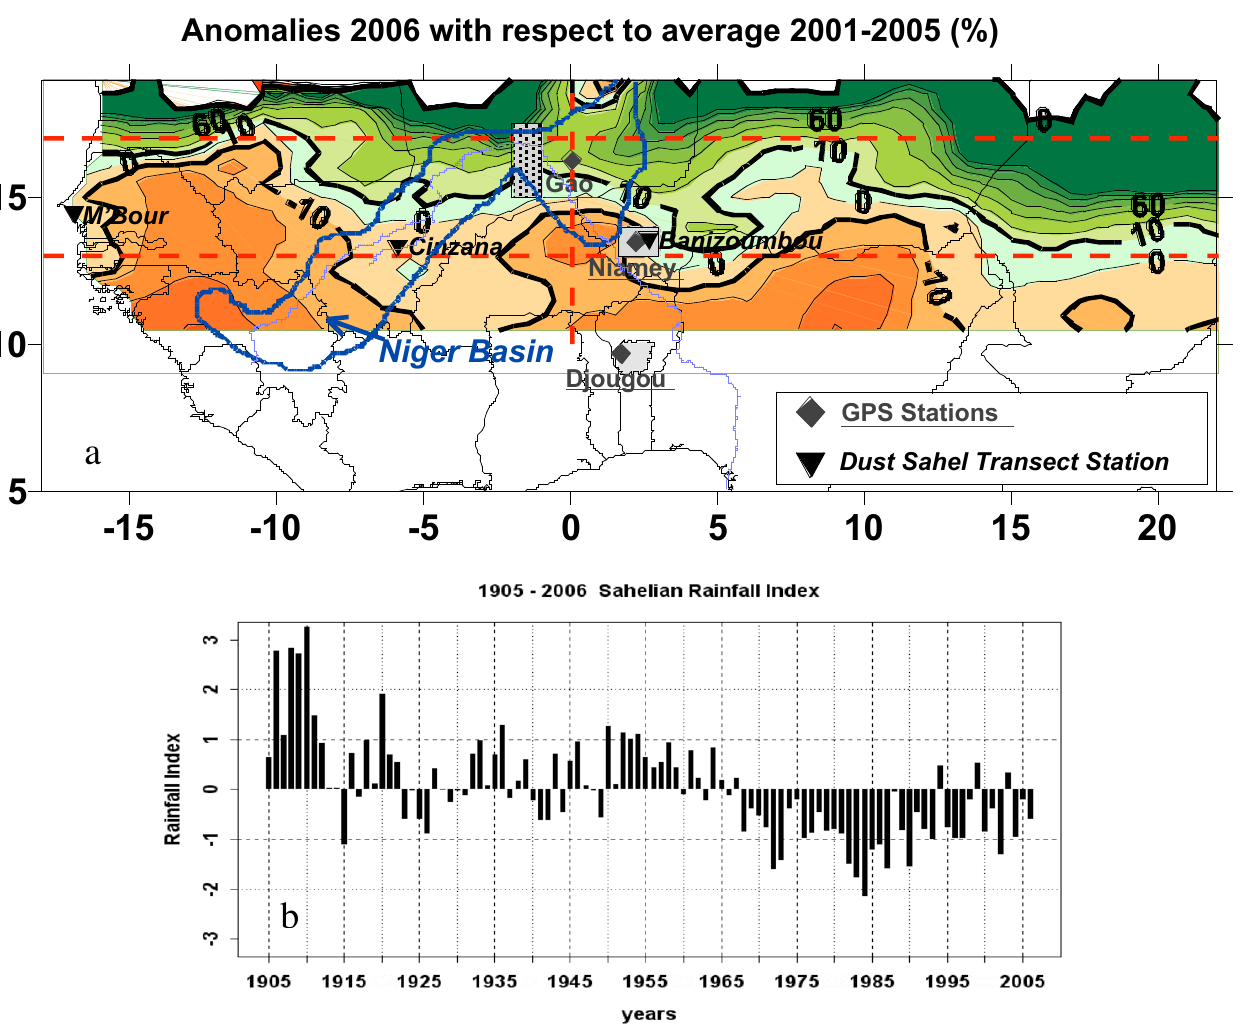
Fig. 1. (a) May–September 2006 rainfall anomalies relative to the period 2001–2005 expressed in %. The grey areas represent the three meso-sites near Djougou, Niamey and Gao. The dark blue contour indicates the limits of the Niger Basin at Niamey where the area of the catchment is 860000km 2 . The other stations (GPS and dust networks) are also indicated. (b) The corresponding May–September Sahelian rainfall index, expressed in normalized anomalies, is computed from 1905 to 2006 by averaging rainfall data between the two horizontal red lines. Source of the data: AGRHYMET.